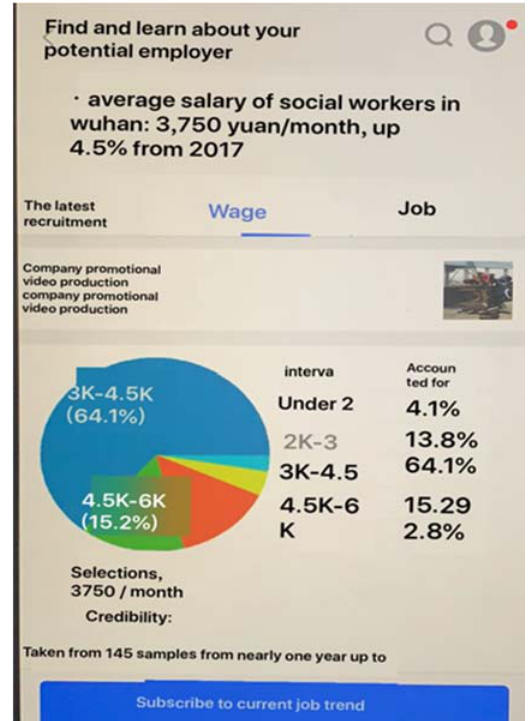
Figure 1. Average Salary of Social Workers in Wuhan, May 2019.